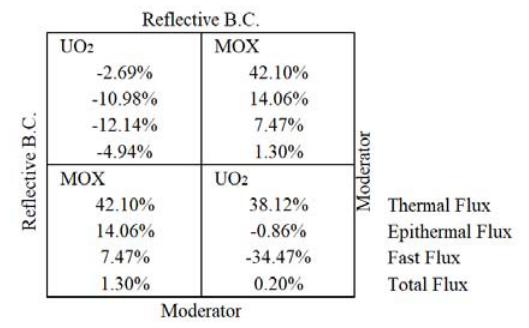
Figure 5. Relative improvement of ADF implementation for flux distribution in modified C5G7 fuel